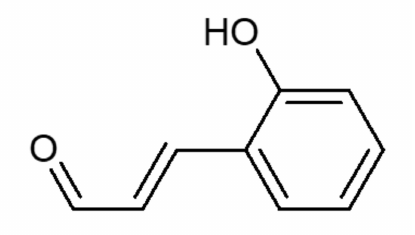
Figure 1. Chemical structure of 2 (cid:48) -HCA. HL-60 human promyelocytic leukemia, Molt-4 human T lymphoblastic leukemia, U937 human histiocytic lymphoma, K562 human erythroleukemia, HepG2 human hep- atoma, SNU-C5 human colorectal adenocarcinoma, A549 human lung adenocarcinoma, and KB human mouth epidermal carcinoma cells were obtained from the Korean Cell Line Bank (KCLB). Cells were cultured in RPMI 1640 DMEM with 10% FBS, penicillin (100 units/mL), and streptomycin sulfate (100 µ g/mL). Cells were maintained at 37 ◦ C in a humidified atmosphere of 5% CO 2